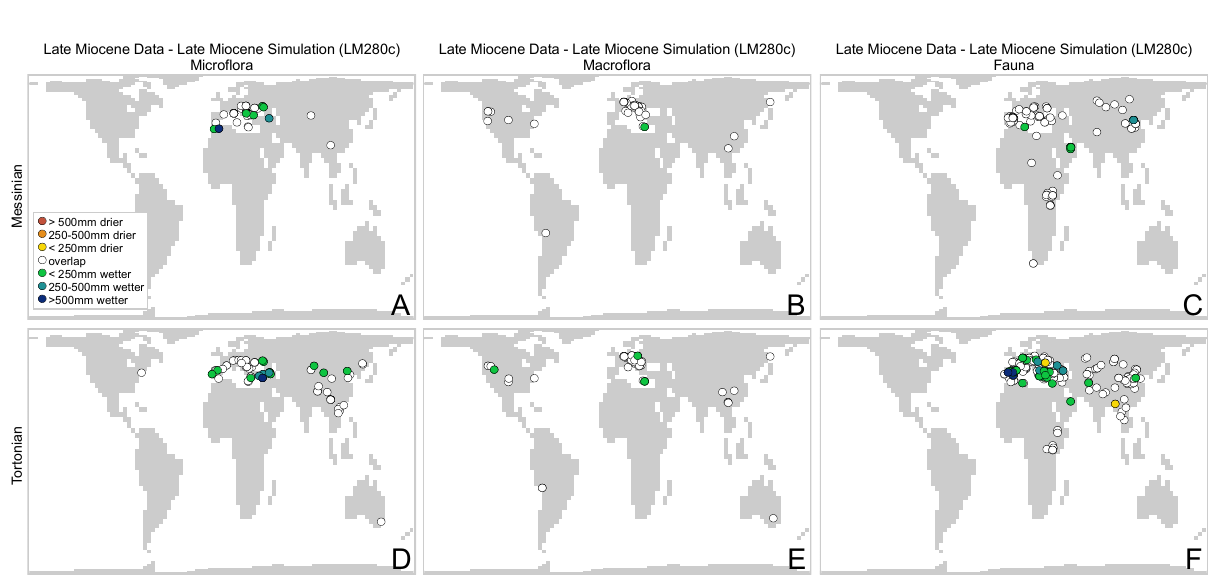
Fig. 12: Results from the model–data comparison for mean annual precipitation, late Miocene data–LM280c.